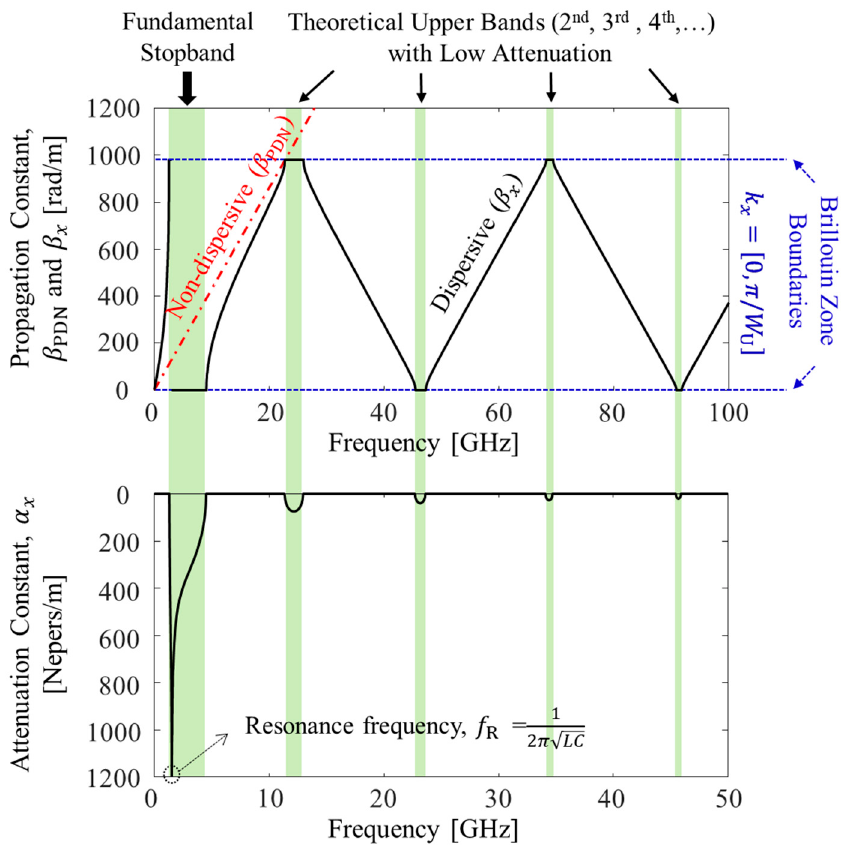
Figure 4. Dispersion diagrams. Without noise suppression structures in the PDN, the power/ground noise is nondispersive. With noise suppression structures, theoretical stopbands are generated. Table 1. Summary of important design parameters and values used to derive dispersion diagrams shown in Figure 4.